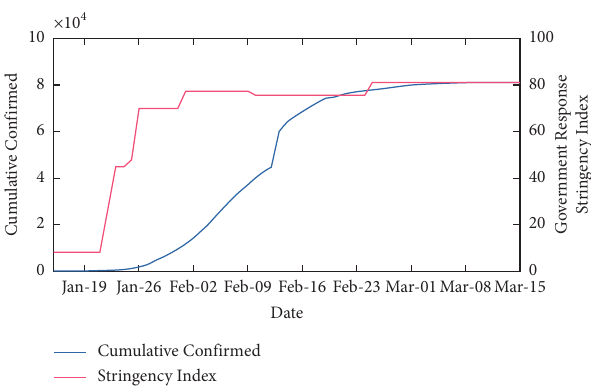
Figure 4: China cumulative confirmed cases and stringency index (January 15, 2020–March 15,